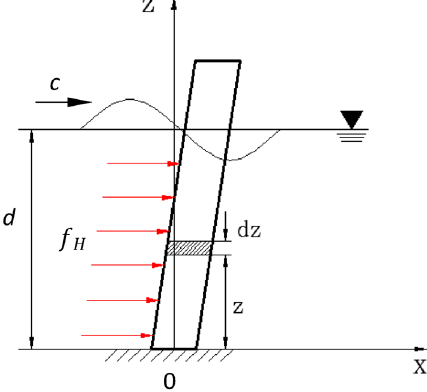
Fig. 4 Force diagram of a single pile leg